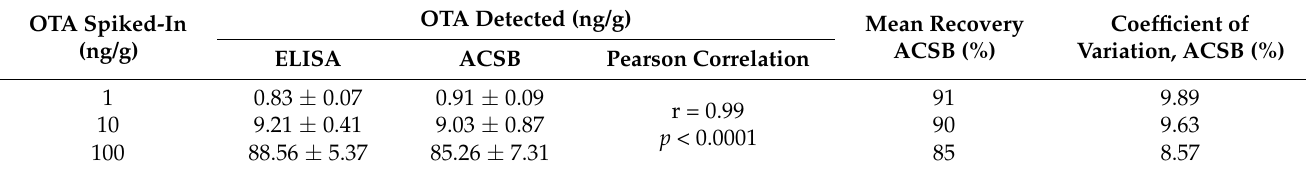
Table 1. Application of biosensor for OTA detection in artificially contaminated